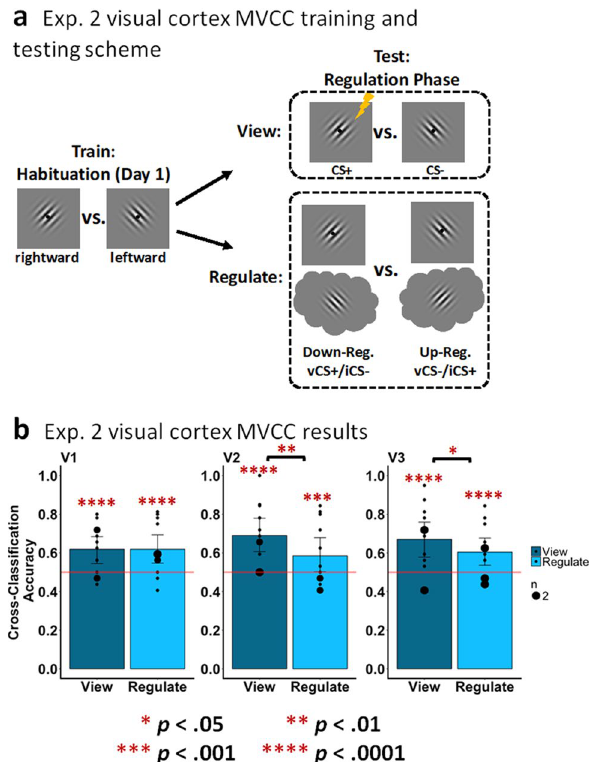
Figure 5. MVCC in early visual cortex during the emotion regulation phase (experiment 2). ( a ) A graphical representation of the MVCC training and testing scheme. The lightning bolt denotes the CS+ though the MVCC analysis excluded trials with shock. ( b ) Results of the MVCC classification of view trials (vCS+ vs. vCS−; dark- gray bars) and regulate conditions (‘down-regulate’ (vCS+/iCS−) vs. ‘up-regulate’ (vCS−/iCS+); light-gray bars) in V1 (bottom-left), V2 (bottom-middle), V3 (bottom-right). The horizontal line represents chance (50%), and the black dots represent how many participants had a given classifier